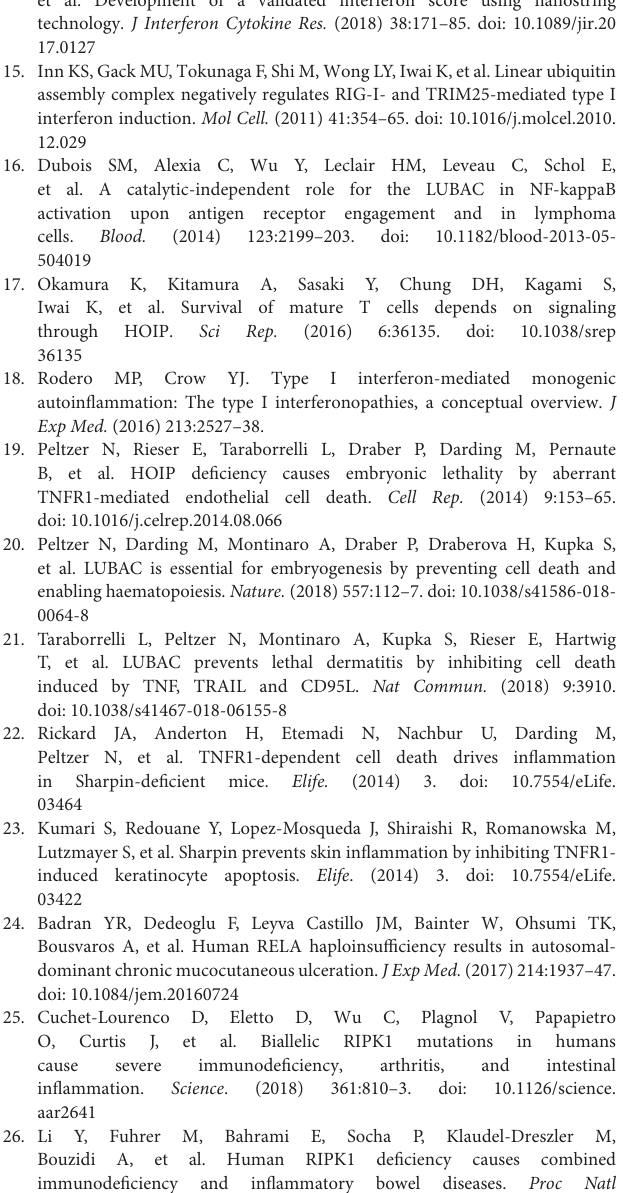
significance (edgeR, p < 0.001). (C) Heatmap showing the expression of 28 genes in whole blood RNA that are known to be upregulated in monogenic type I interferonopathies. Figure S8 | Expression levels of TRIM25 in unstimulated PBMCs of the HOIP deficient patient. HeLa cell extract was used as a positive control for the western blot. C, unrelated healthy control; P, HOIP deficient patient. Table S1 | Phenotypic comparison of the LUBAC deficiency patients with immune dysregulations. Table S2 | Lymphocyte surface markers. Table S3 | Upstream pathway terms enriched in the HOIP deficient patient’s